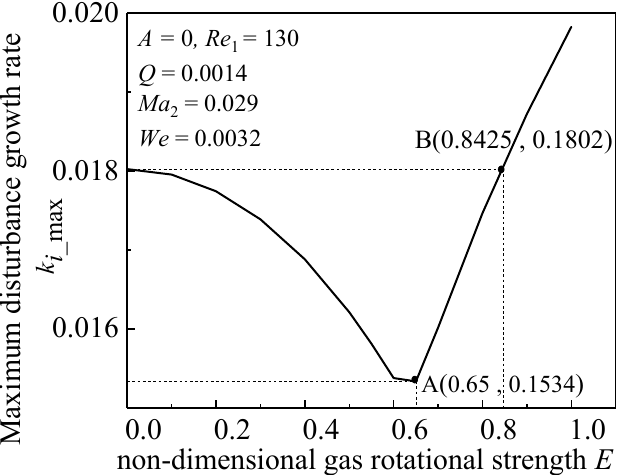
Figure 6. The maximum disturbance growth rate under the dominant mode versus the different airflow rotation